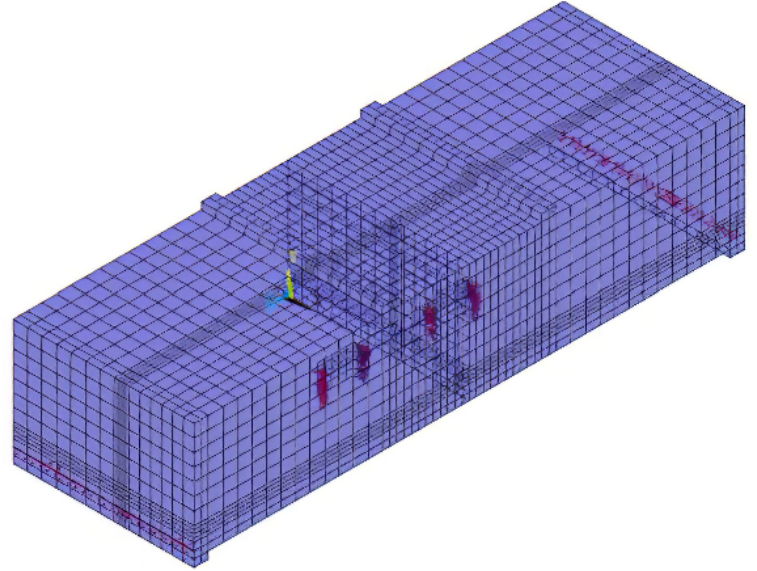
Figure 9. Crack development at the initial stage of joint stress.